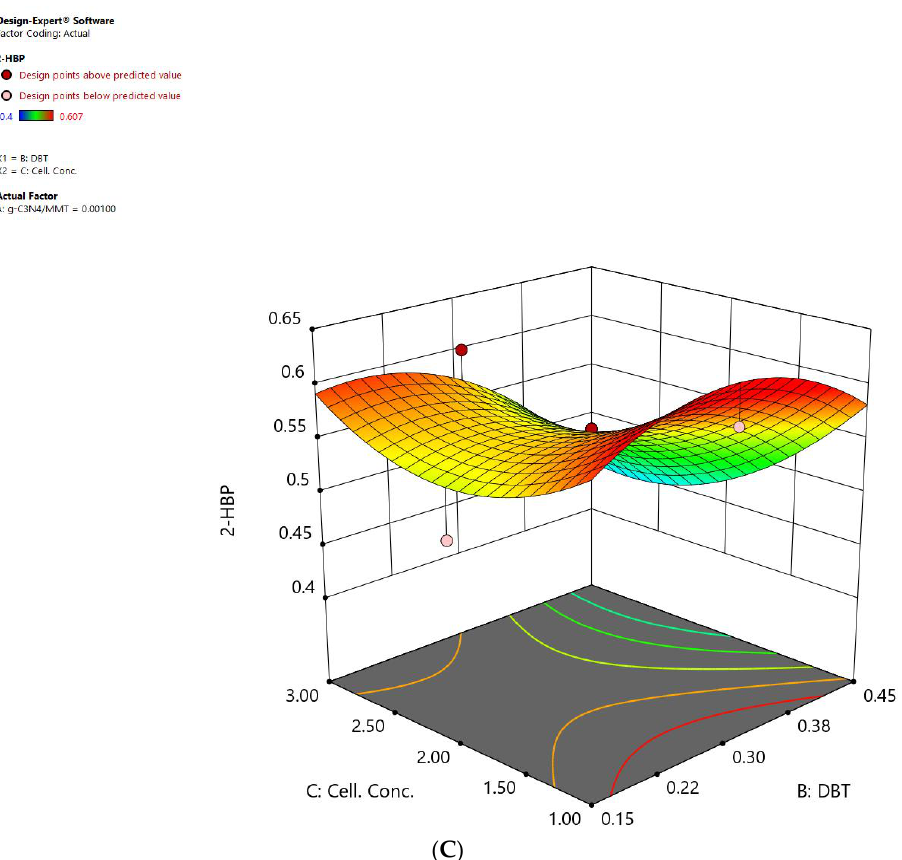
Figure 4. ( A ) Three-dimensional plot of interactions of A: concentration of nanostructure (MMT/g-C 3 N 4 ) and B: concentration of sulfur (DBT). ( B ) Three-dimensional plot of interactions of A: concentration of nanostructure (MMT/g-C 3 N 4 ) and C: cell concentration. ( C ) Three-dimensional plot of interactions of B: concentration of sulfur (DBT) and C: cell concentration.